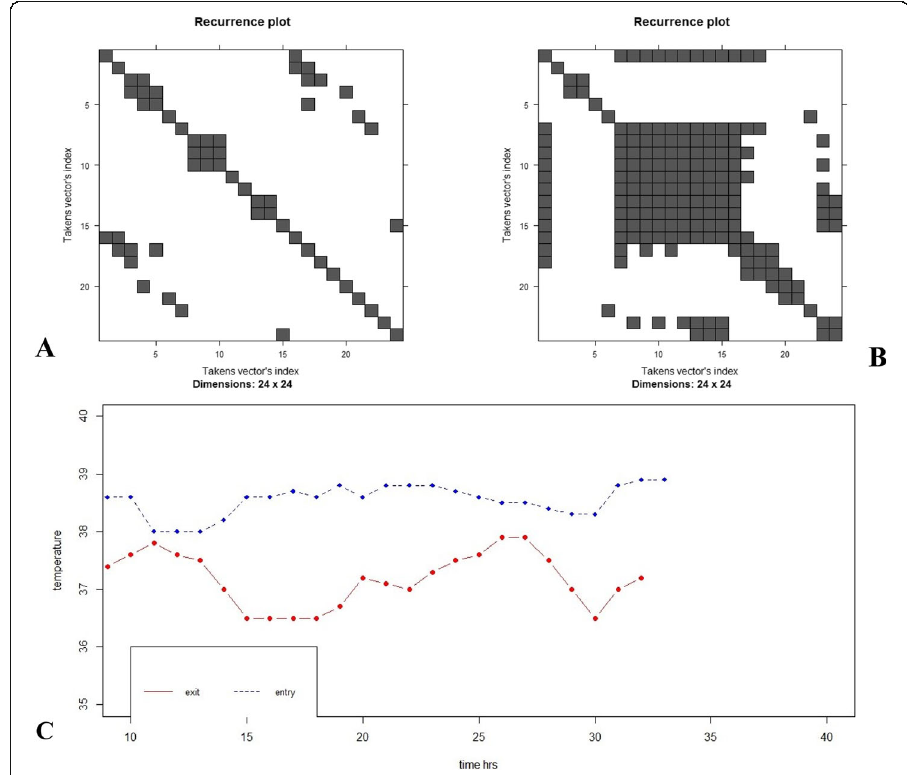
Fig. 3 Recurrence plot (RP) of CBT curves of a patient from group A (initial septic shock). a Entry RP. b Exit RP. Both x and y axes denote time (24 h of measurements). It seems by simple inspection that upon entry, there are less diagonal and vertical lines and more single recurrence dots, whereas during exit, the combination of numerous vertical and horizontal lines forms rectangular clusters of recurrence points, indicating more periodicity of CBT curves. c CBT longitudinal values over 24 h. Blue corresponds to entry and red to exit. Measurements started at around 9.00 a.m. It seems that the trace during exit is less smooth and more “ erratic ” than that during entry. This might signal an increased rhythmicity with many fluctuations upon exit from the ICU and is associated with a more periodic pattern of CBT change in RQA analysis, depicted in b . Takens vector ’ s index in temperature as a single variable describing the systems ’ dynamics and projected in a two-dimensional phase space (see text for